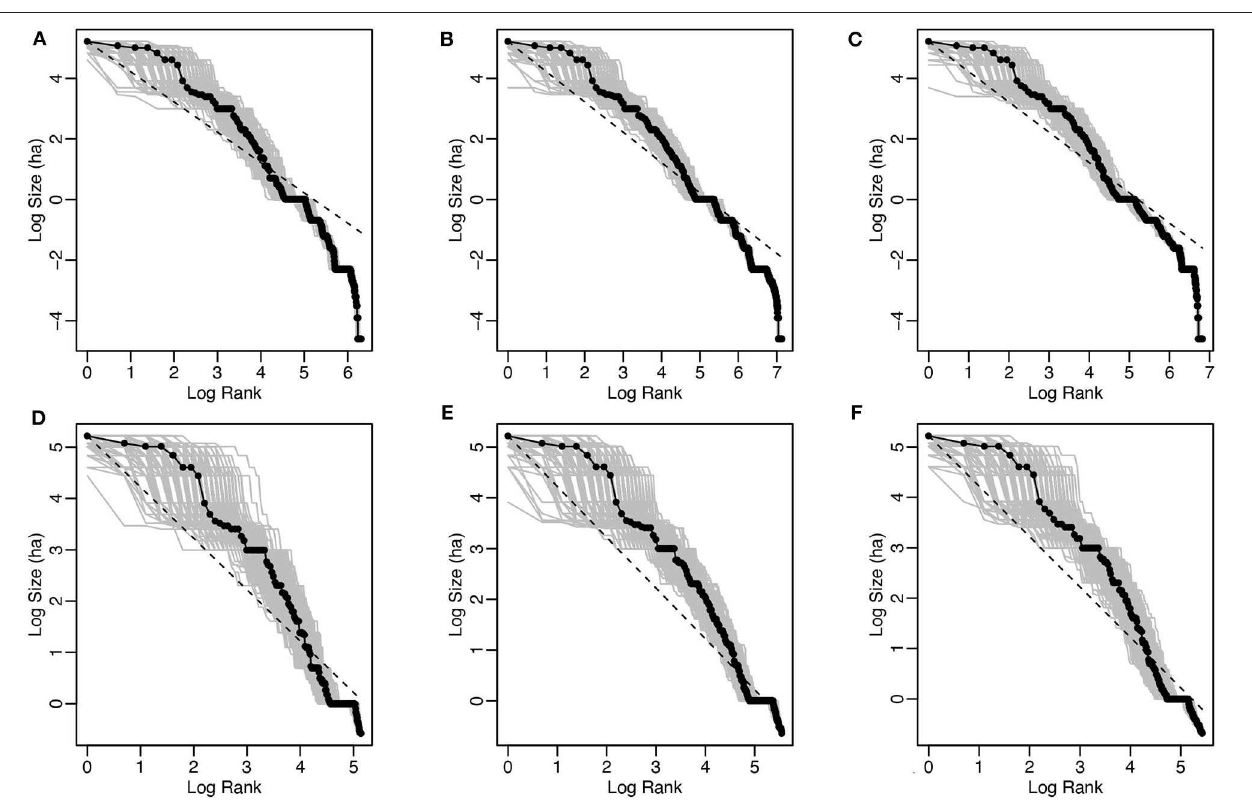
FIGURE 6 | Rank size in Etruria. (A) All sites in the Iron Age and Orientalizing. (B) All sites in the Archaic period. (C) All sites in the Post-Archaic Period. (D) All sites larger than 0.5 ha. in the Iron Age and Orientalizing. (E) All sites larger than 0.5 ha. in the Archaic period. (F) All sites larger than 0.5 ha. in the Post-Archaic period. The dark line represents the observed data. The grey lines represent the bootstrap results performed on random samples of sites.